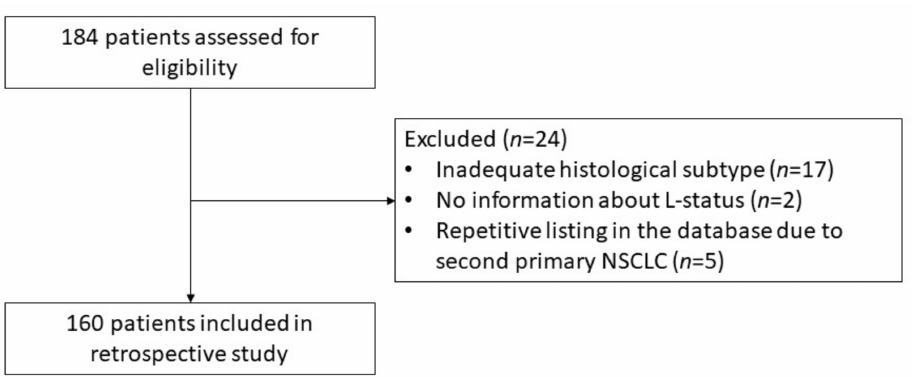
Figure 1. Consort diagram visualizing the exclusion of patients. Abbreviations: L, Lymphatic Invasion; NSCLC, Non-Small Cell Lung